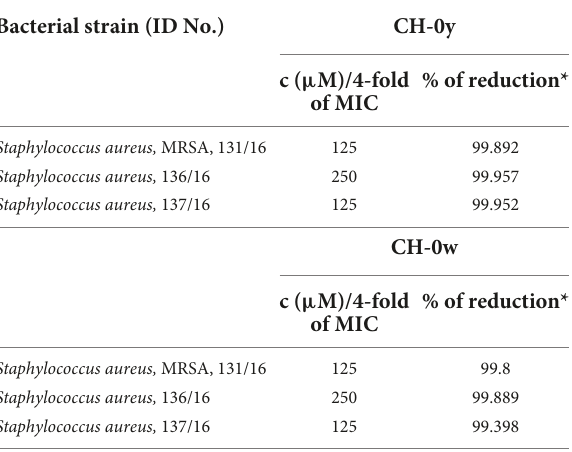
TABLE 2 Reduction of the staphylococcal viability after 24-h exposure to 4-fold of a minimum inhibitory concentration of CH-0y and